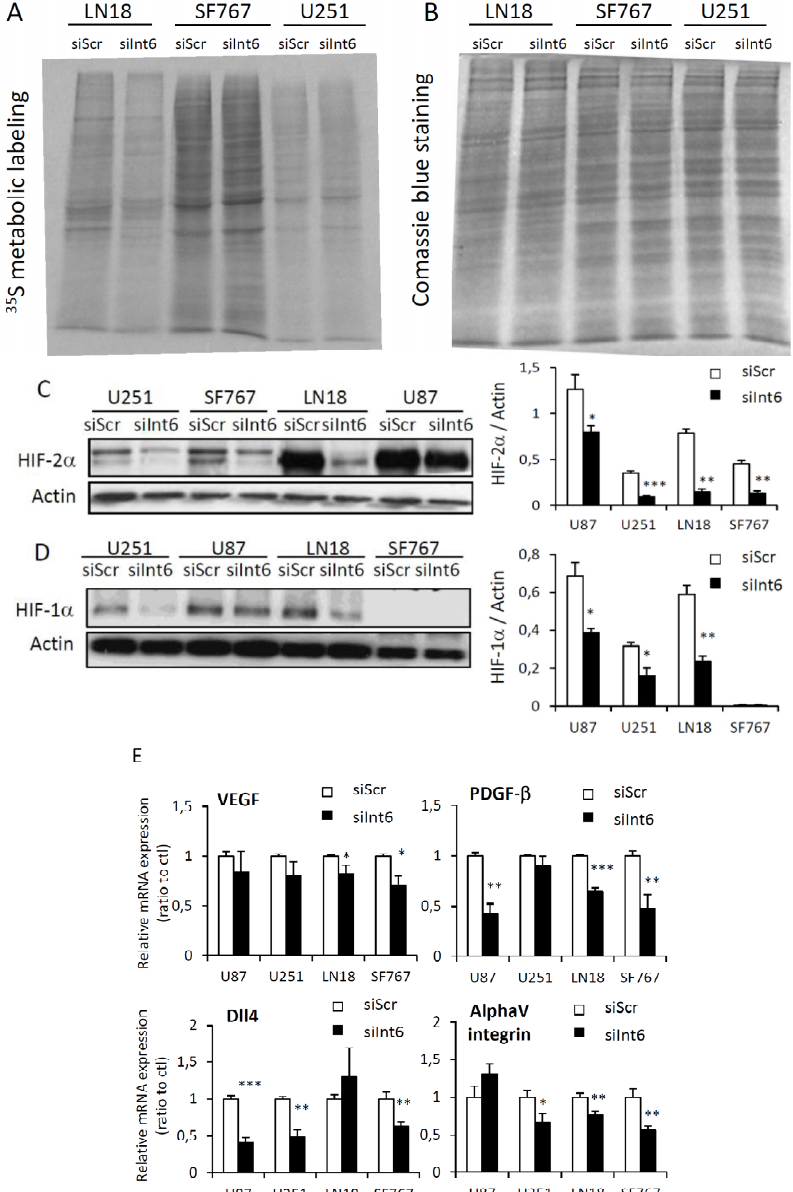
Figure 6. Int6 gene silencing downregulates the Hypoxia Inducible Factors expression without affecting global cell translation. ( A , B ) De novo protein synthesis in GBM cell lines (72 h after siScr or siInt6 transfection) was assessed by 35 S Methionine metabolic labeling. Proteins were resolved by SDS-polyacrylamide gel, autoradiographed ( A ) and stained with Coomassie ( B ); ( C , D ) Western blot analysis of HIF-2 α ( C ) and HIF-1 α ( D ) expression in human GBM cells transfected or not with siInt6 showing decreased HIF expression when Int6/EIF3E is knockdowned, n = 5; ( E ) Graphs representing HIF target gene ( VEGF , PDGF- β , Dll4 , α V integrin ) expression in control or Int6 silenced GBM cells, assessed by qRT-PCR. Int6 inhibition significantly reduces HIF target gene expression. (* p < 0.05, ** p < 0.01, *** p < 0.001, n =